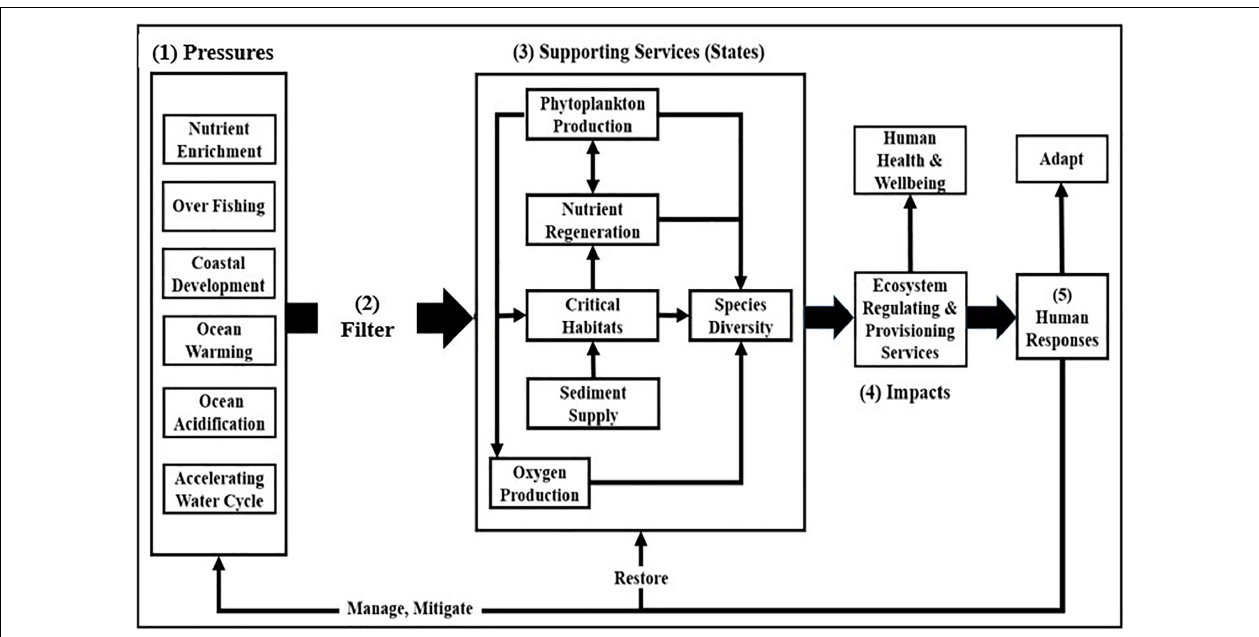
FIGURE 1 | The framework is conceptualized in terms of (1) anthropogenic pressures on ecosystem support services that (2) are uniquely modulated by each ecosystem as they perturb (3) ecosystem support services (states), changes in which impact (4) regulating and provisioning services. Human responses to these impacts (5) include efforts to manage and mitigate pressures, to restore supporting services, and to adapt to changes in states (modified after Cloern, 2001).